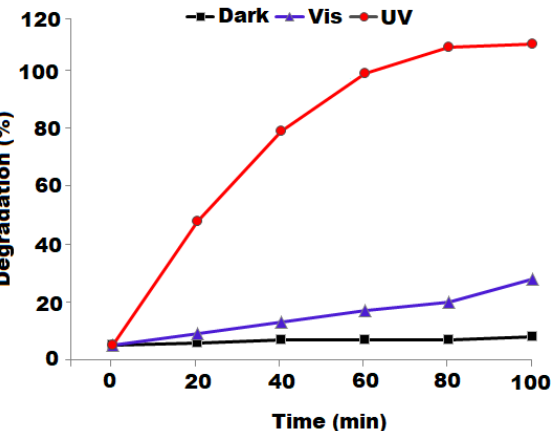
Figure 5. Influence of light source on MB photodegradation employing the biosynthesized Al 2 O 3